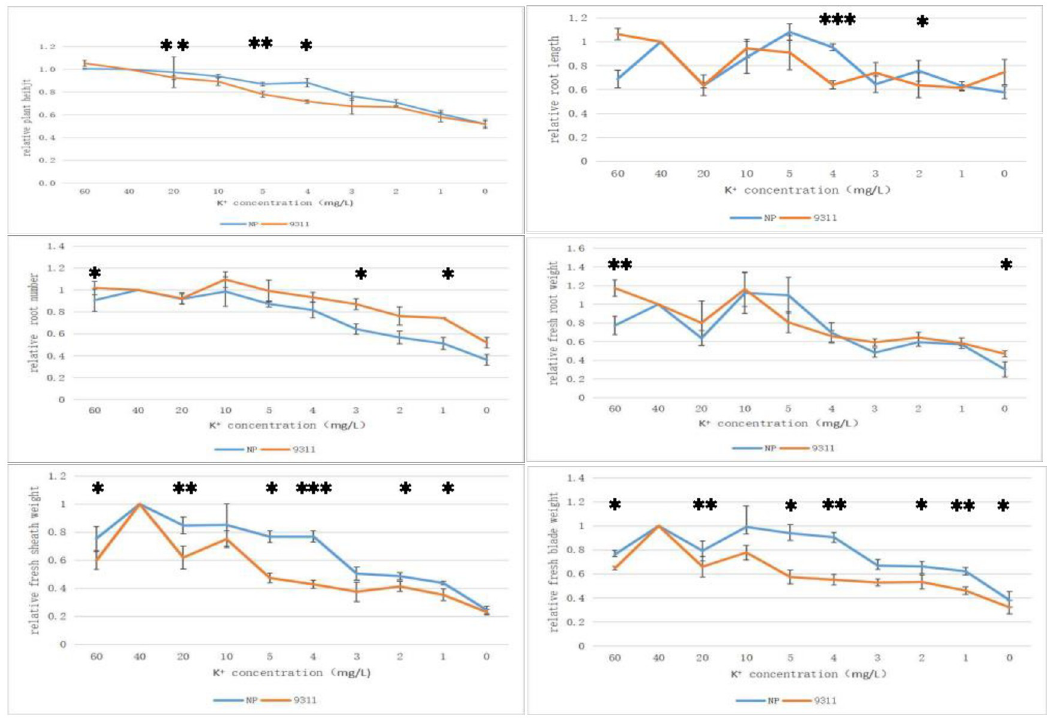
Fig 5. Significance analysis of six parameters of NP and 9311 in different potassium concentration culture solution. * : Significant difference at 0.05 level; ** : Very significant difference at 0.01 level; *** : Highly significant difference at 0.001 level.